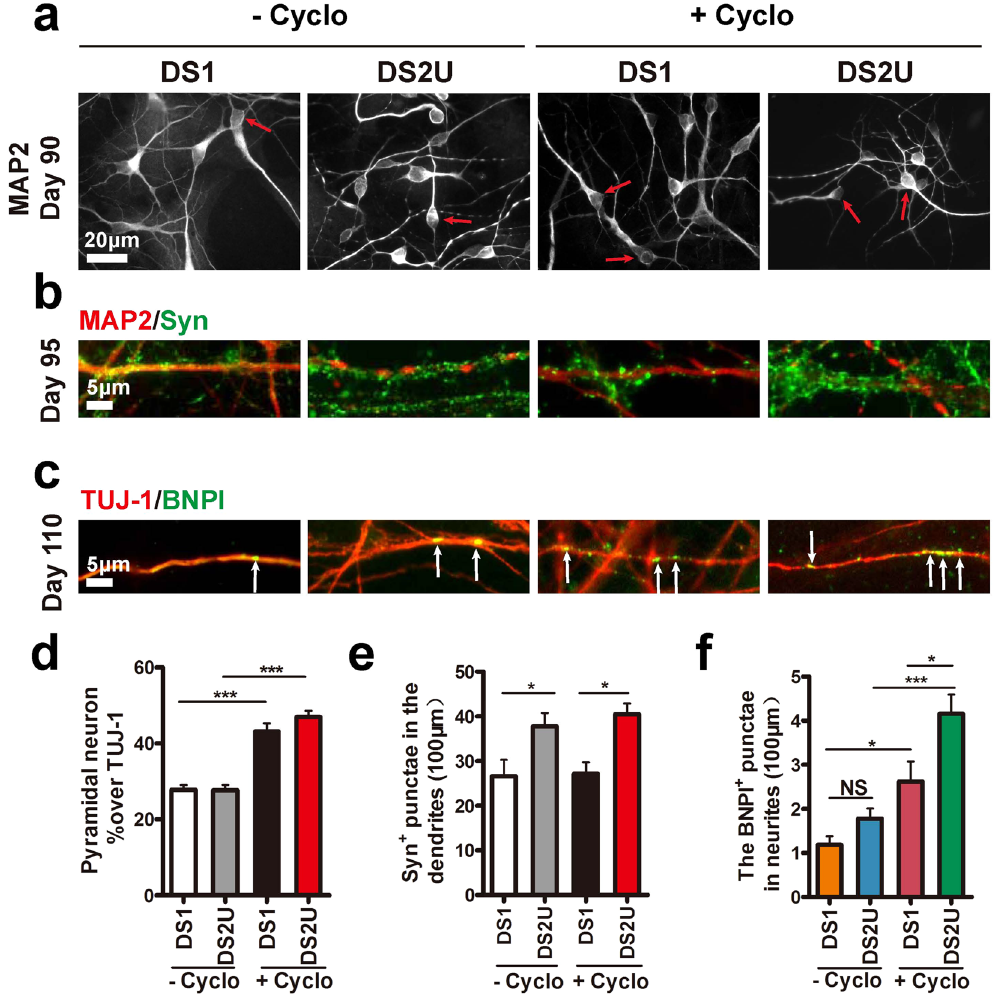
Figure 5. Cyclopamine enriched Down syndrome patient iPSC-derived glutamatergic neurons that exhibited the reduction of vesicular glutamate transporters. ( a ) Mature cortical neurons exhibited pyramidal morphology (arrows) from d90. Scale bar, 20 μ m. ( b ) Mature neurons expressed MAP2 and synaptophysin from d95. Scale bar, 5 μ m. ( c ) Glutamatergic neurons expressed BNPI (arrows) from d110. Scale bar, 5 μ m. ( d ) Proportion of pyramidal neurons in total neurons. *** p < 0.001. More than 500 neurons from random fields were manually counted in each condition. The data are presented as the mean ± s.e.m, n = 3 in each condition. ( e ) Fewer synaptophysin + puncta in DS1 neurons compared to DS2U neurons. * p < 0.05. More than 26,000 μ m of MAP2 + dendrites from random fields were manually counted in each condition. The data are presented as the mean ± s.e.m, n = 3 in each condition. ( f ) Less BNPI + puncta in DS1 compared to DS2U cortical neurons with cyclopamine treatment. * p < 0.05; *** p < 0.001. More than 16,000 μ m of TUJ-1 + neurites from random fields were manually counted in each condition. The data are presented as the mean ± s.e.m, n = 3 in each